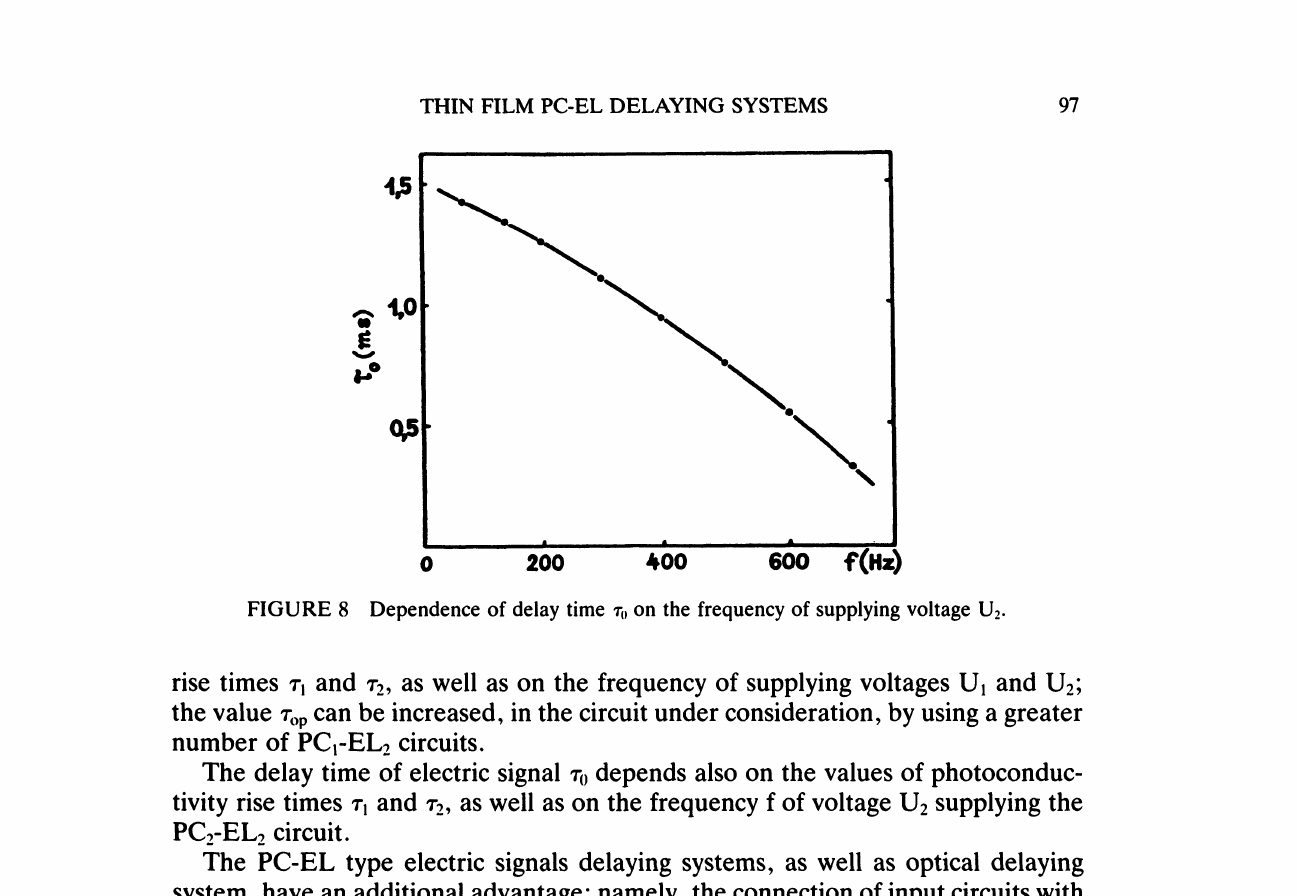
FIGURE 8 Dependence of delay time